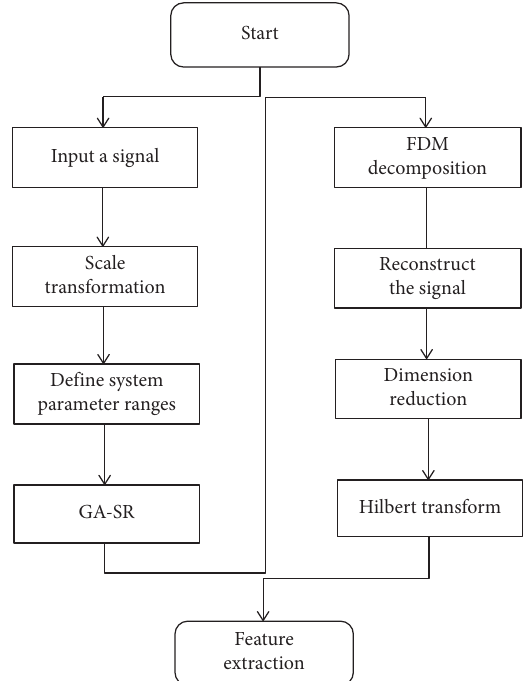
Figure 1: Flowchart of signal feature extraction for hydropower